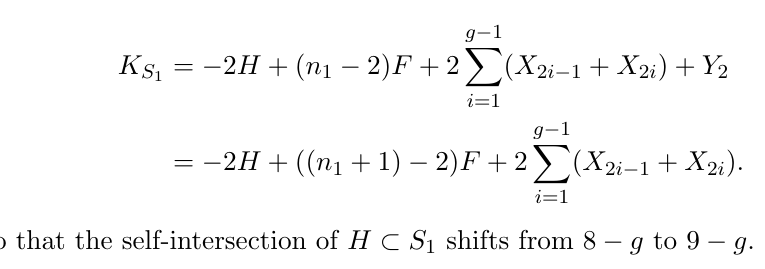
Figure 6. Hanany-Witten transition from F 2 to F 0 . The transverse (0 ; 1) 7-brane, and the dashed line denotes the location of the 7-brane monodromy cut. the curve F Y 2 S 1 , we compute the canonical (cid:0) (cid:26)